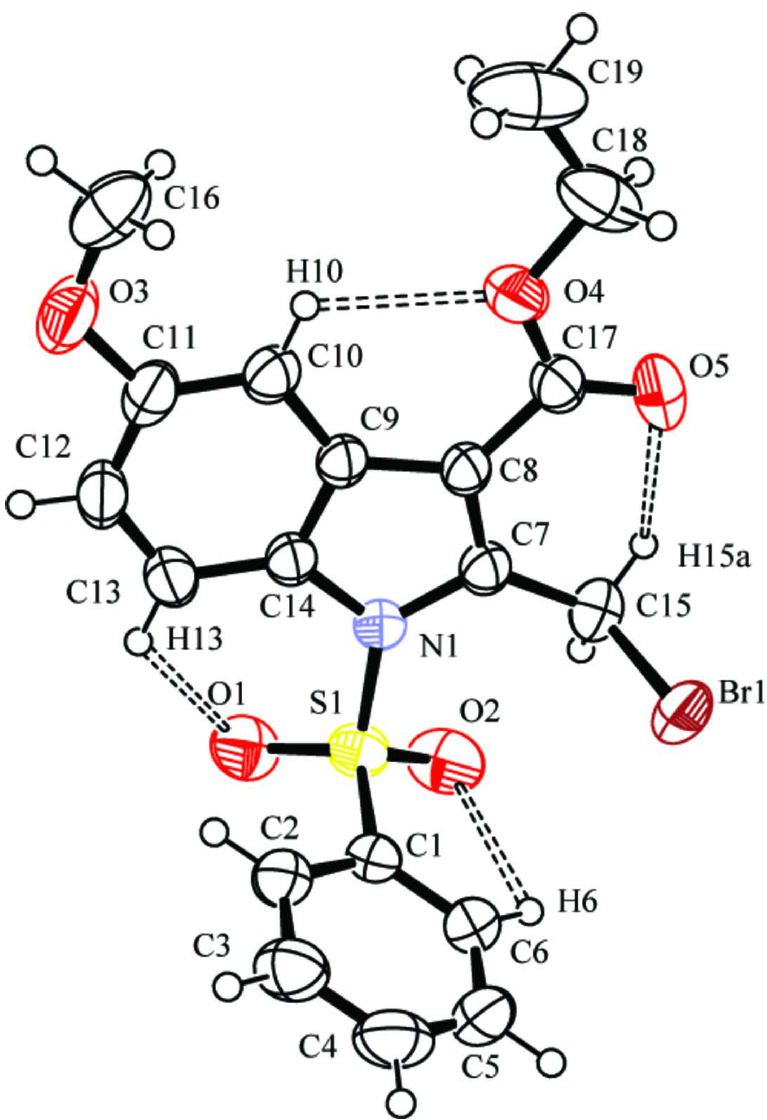
Figure 1 The molecular structure of I , with atom labeling scheme. Displacement ellipsoids are drawn at 50% probability level. H atoms are presented as a small spheres of arbitrary radius. Only major fragment for disordered Br1 and C15 are drawn. Intramolecular H–bonds are shown as dashed